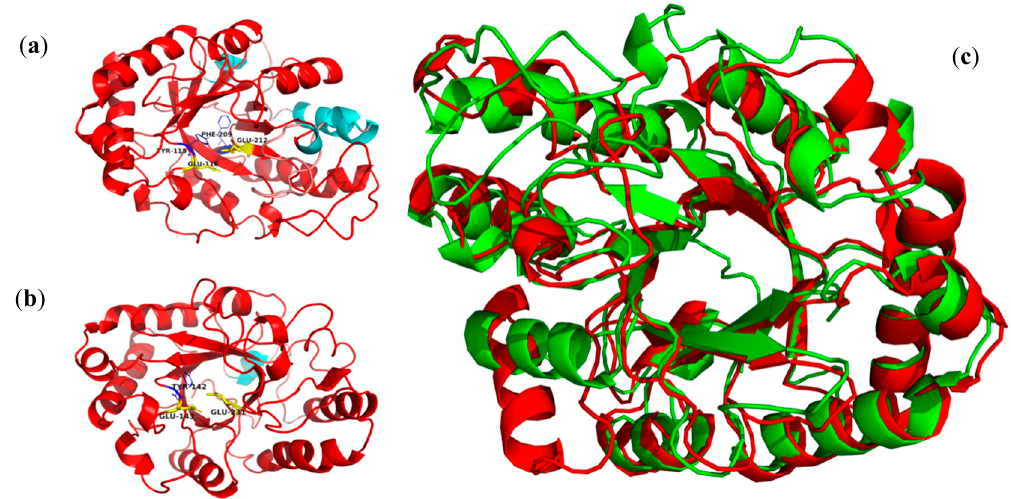
Figure 11. The 3D structure and alignment of the rXYL4 and Xyl88. ( a ) the 3D structure of rXYL4, ( b ) the 3D structure of Xyl88, ( c ) the 3D structure alignment, rXYL4 colored with green and Xyl88 with red.